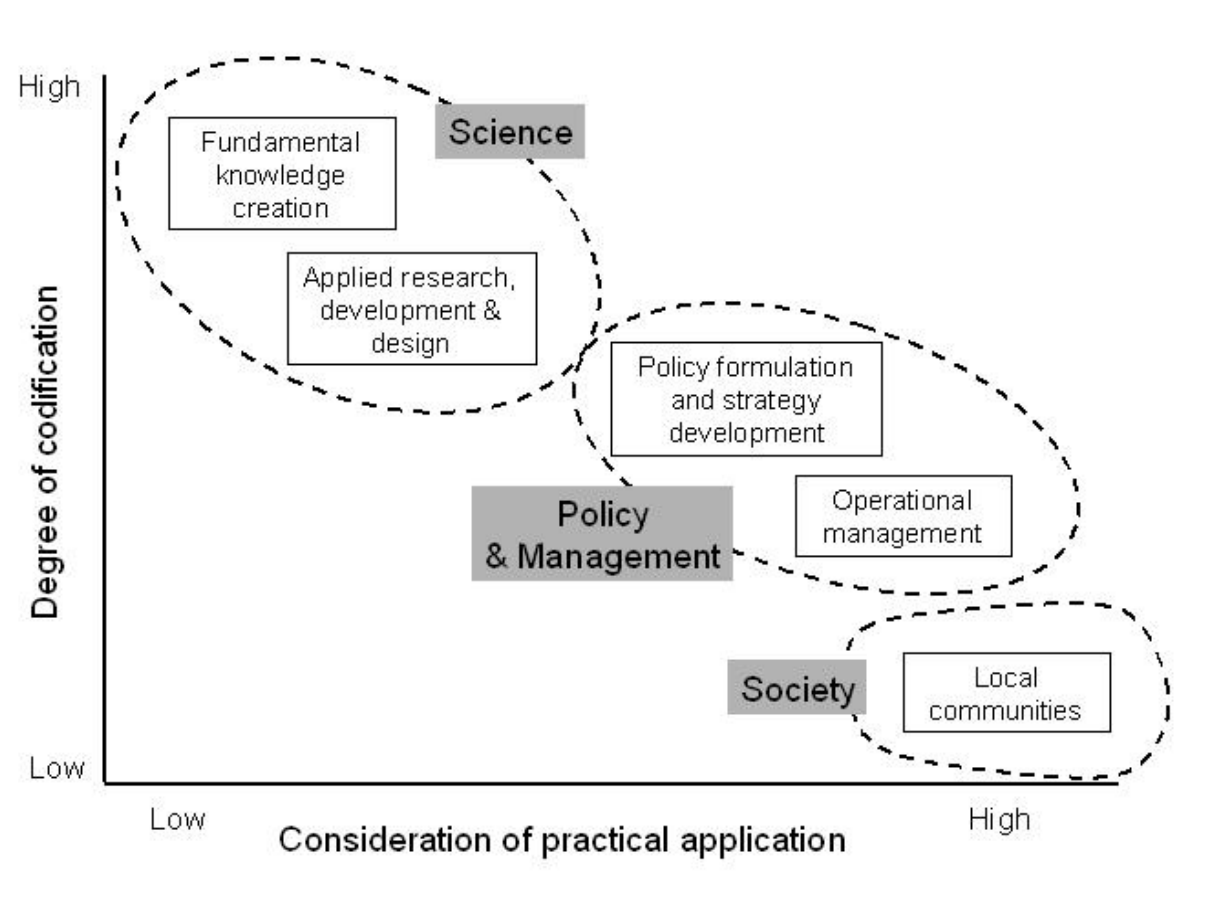
Fig. 2. Various domains involved in managing ecological resources differ in their degree of knowledge codification, or explicitness, and emphasis on practical